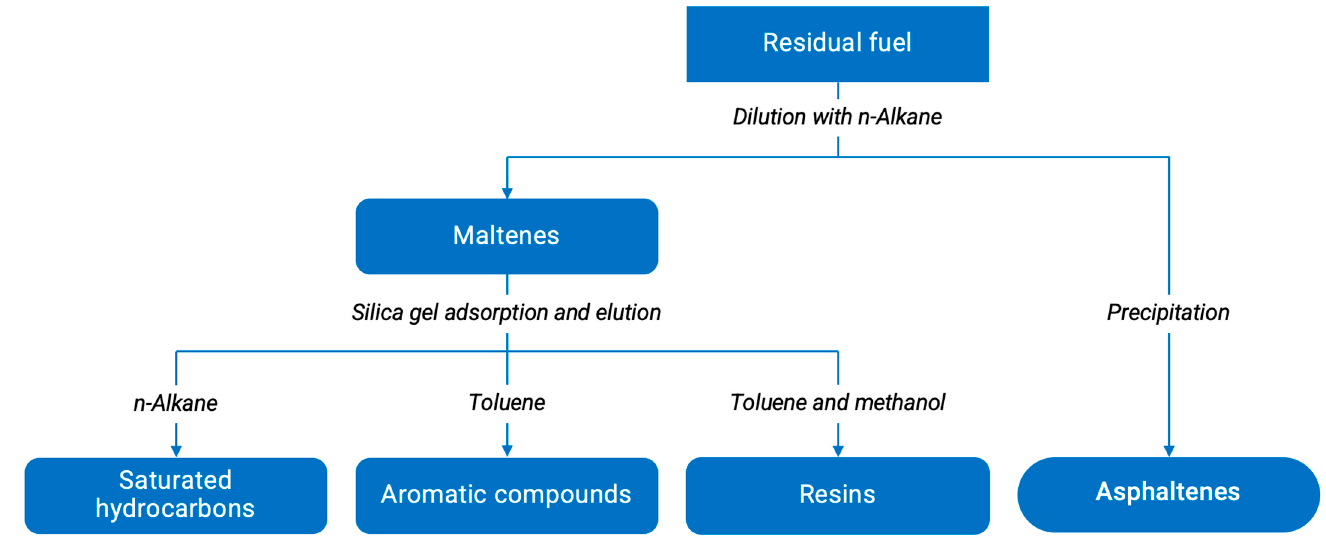
Figure 1. Residual fuel dilution scheme to determine the group composition of fuels.